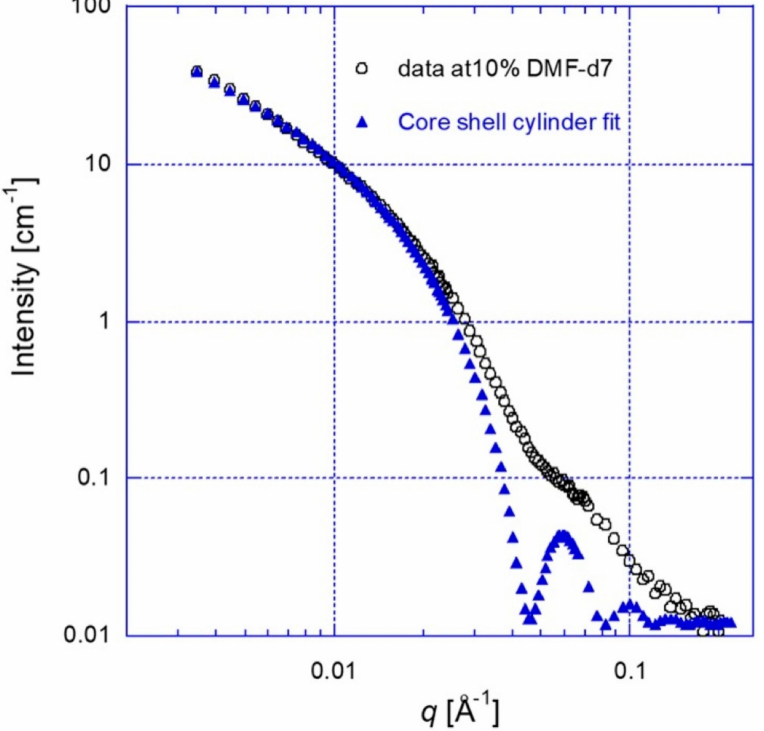
Figure 10. A core–shell cylinder model fit to the 0.5 wt.% MWCNT + 1 wt.% S4 12 -VP 12 scattering data at 10 wt.% DMF-d7 solvent (background